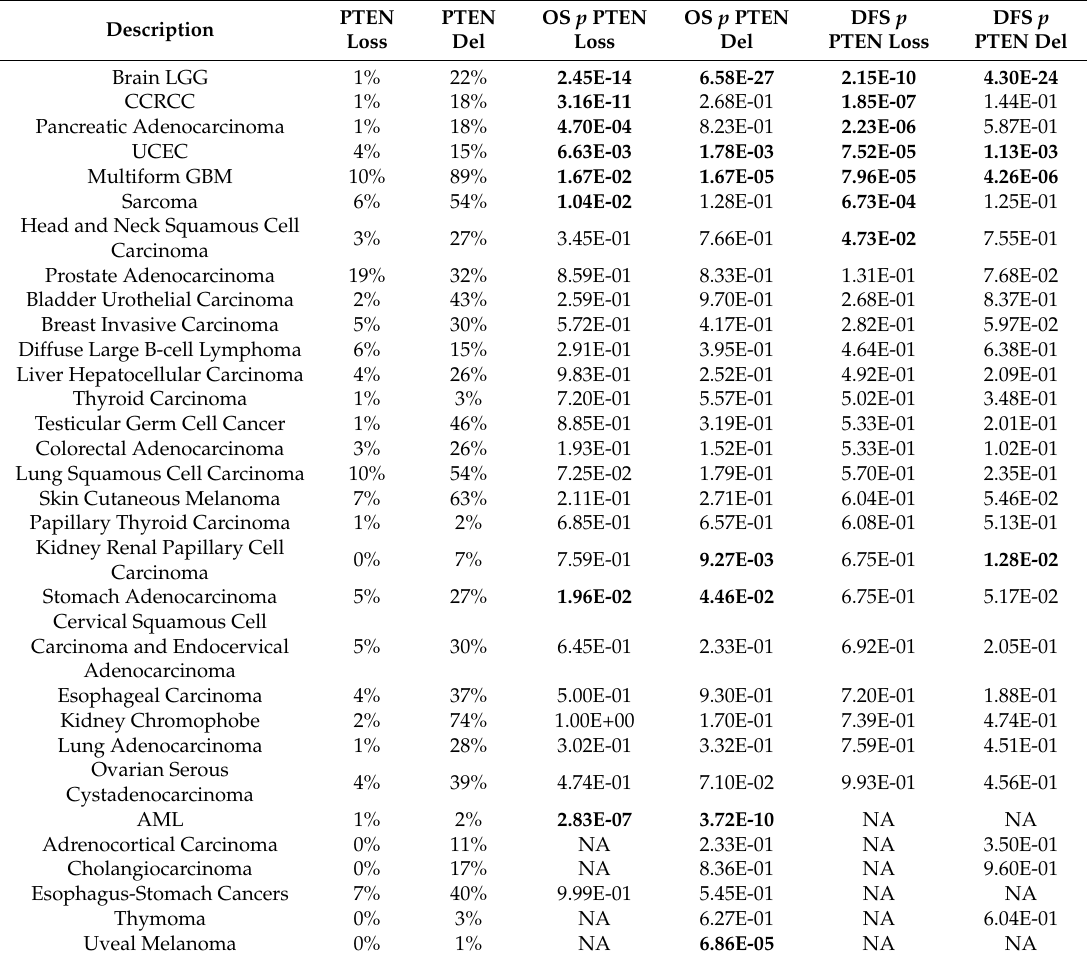
Table 2. Pan-cancer analysis of PTEN deletion prognostic